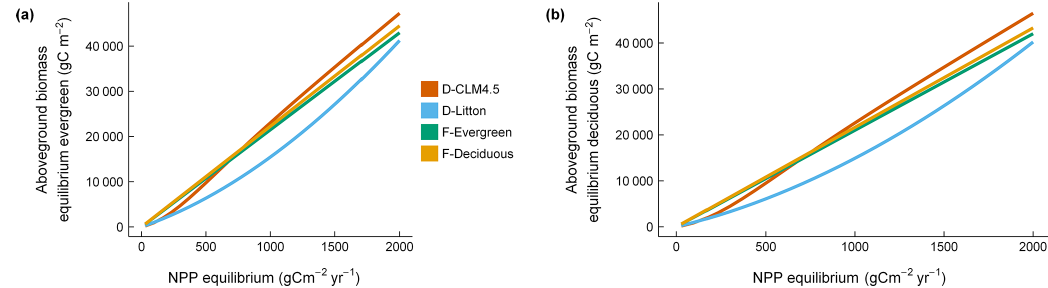
Figure 9. The C allocation scheme determines aboveground biomass C at equilibrium for (a) evergreen and (b) deciduous sites. For the deciduous sites, with NPP at equilibrium conditions, the D-Litton allocation scheme is closer to the observed aboveground biomass values in 1980 (see Fig.